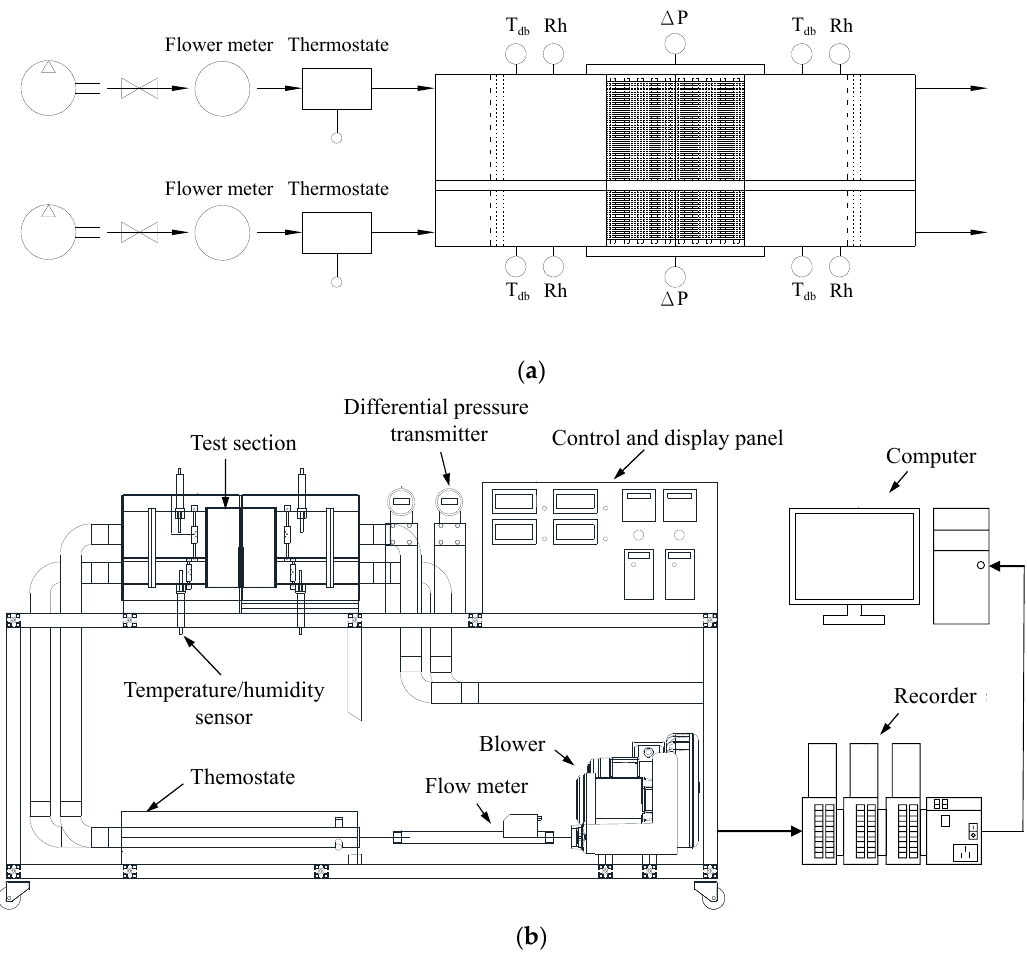
Figure 3. The schematic diagram of the ( a ) experimental setup and the ( b ) piping configuration in this study.